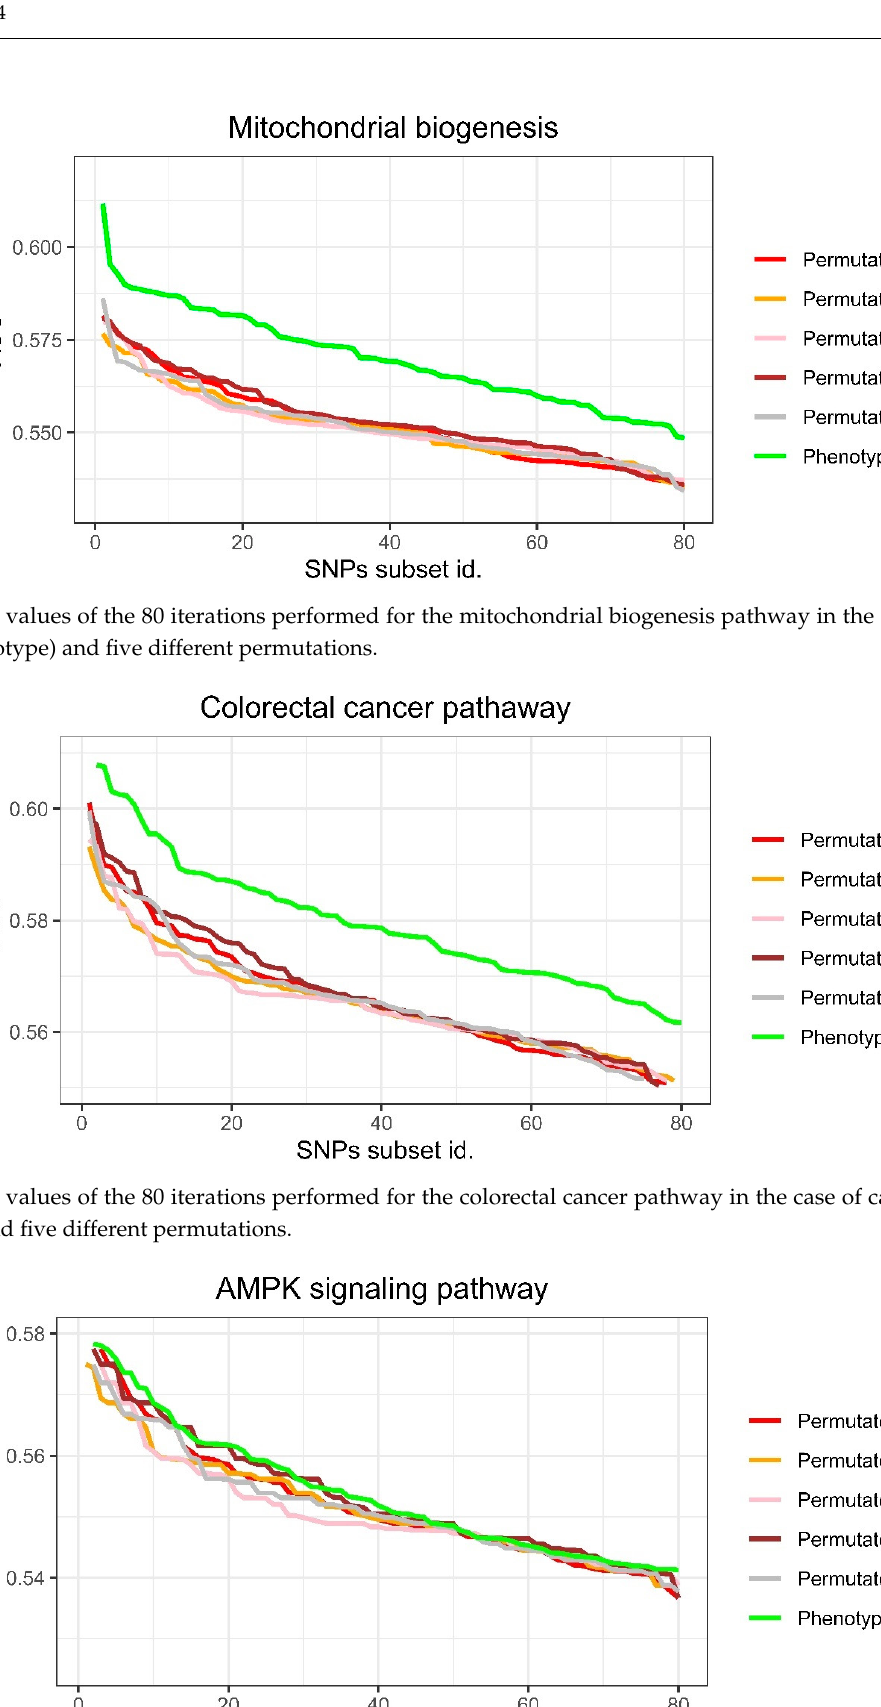
Figure 10. AUC values of the 80 iterations performed for the glucagon signaling pathway in the case of cases and controls (phenotype) and five different permutations. In summary, taking into account the results obtained with the algorithm proposed in the present research, it can be said that there is a clear relationship linking apelin signal- ing, colorectal cancer and mitochondrial biogenesis pathways with colorectal cancer. A weak relationship with colorectal cancer was found for AMPK signaling, glucagon signal- ing, Huntington’s disease and insulin signaling pathways. Finally, no relationship with colorectal cancer was found for adipocytokine signaling, insulin resistance or longevity- regulating pathways.